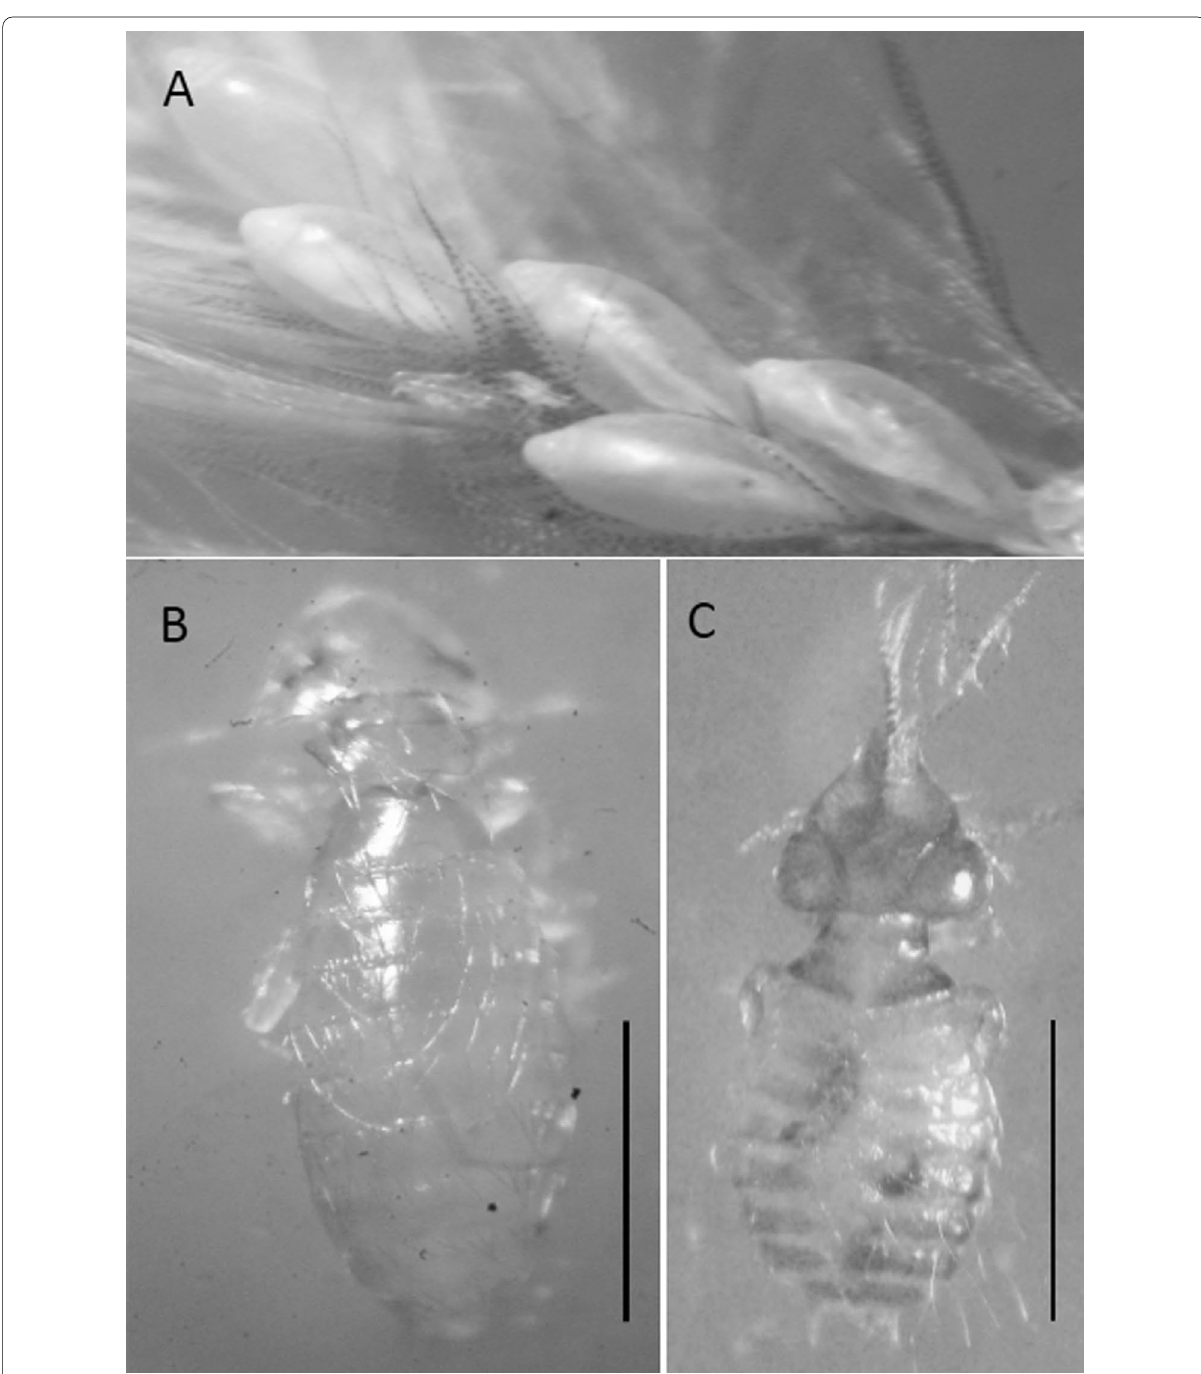
Fig. 1 A Amphora shape eggs of Myrsidea balati with an operculum, glued underside the rachis of feathers, photograph of ( B ) Myrsidea balati and ( C ) Sturnidoecus ruficeps. Line bar in 0.5